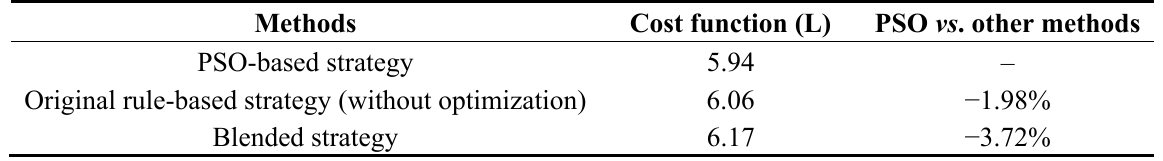
Table 5. Optimization results in the ARB02 driving cycle.